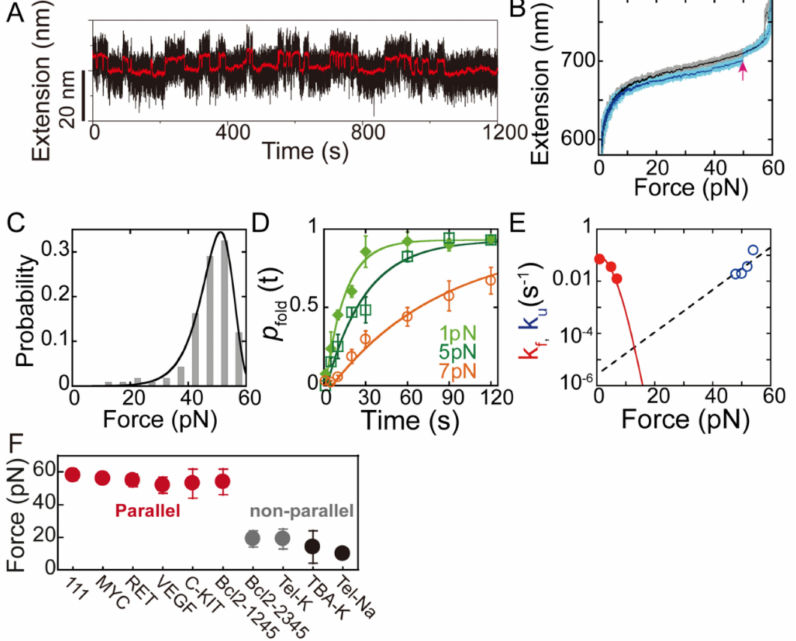
Figure 3. Folding/unfolding kinetics of G4s obtained from force–spectroscopy measurements. ( A ) Force-clamp experiments. Extension of a telomeric G4s in 100 mM KCl buffer held at a constant force of 5 pN fluctuated between folded (low extension) and unfolded (high extension). The red lines show smoothed time traces. The extension record yielded the probability distribution p(x) and the lifetime of folded and unfolded states. (Adapted with permission from [61], Oxford Academic). ( B ) Force-ramp measurement. A representative trajectory of a c-Myc G4s was obtained by a linearly increased force of 0.2 pN/s (cyan). The sudden extension jump (red arrow) is the G4 unfolding signal. ( C ) Unfolding force histogram of Myc2345 G4s. ( D ) The time-evolution of folding probability measured at different forces. ( E ) Force-dependent folding and unfolding rates of Myc2345 G4s. The k f was fitted based on the Arrhenius law and force response of ssDNA and G4s. The k u was fitted using Bell’s model. (( B – E ), adapted with permission from [94], American Chemical Society). ( F ) The major unfolding force peak of representative G4s. (Adapted with permission from [98], American Chemical